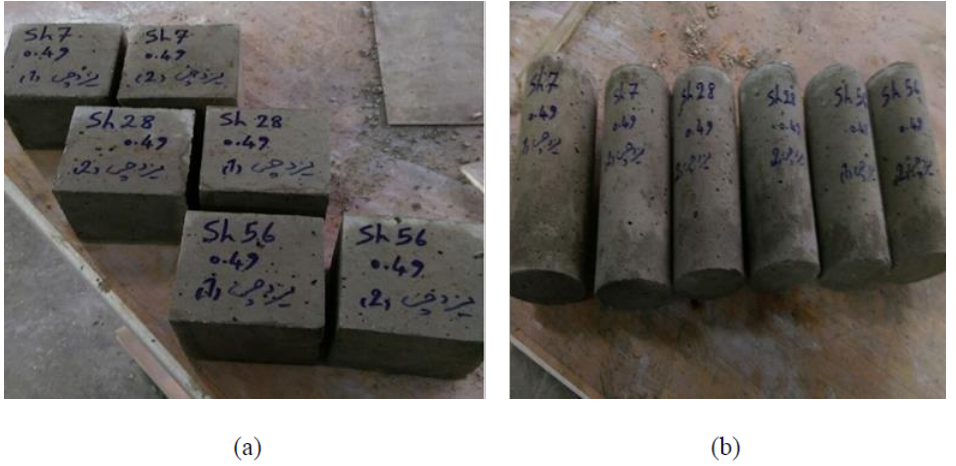
Figure 2. Concrete samples: ( a ) cubic samples, ( b ) cylindrical samples.